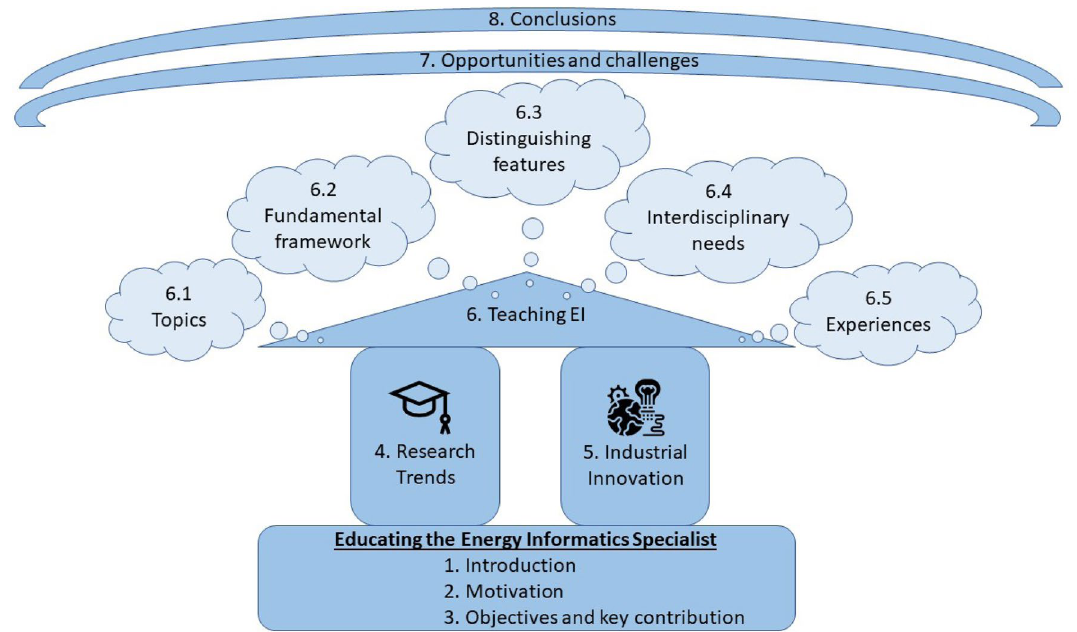
Fig. 1 Structure of the paper. Sections and subsections ordered from the bottom to the top